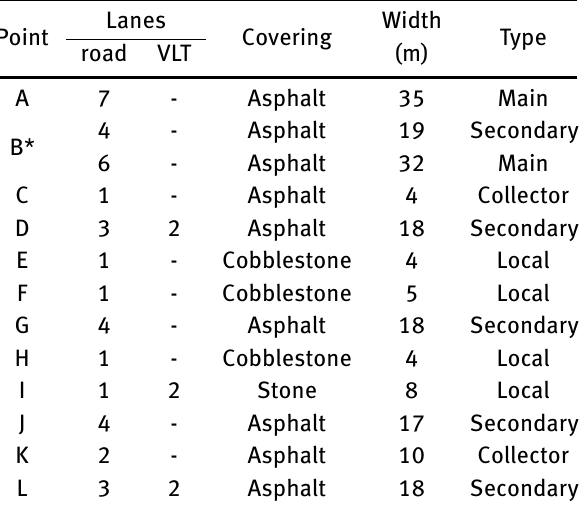
Table 2: L Aeq,5min comparison between measurement (M), along 5 minutes per location, and simulation (S) for both scenarios, in